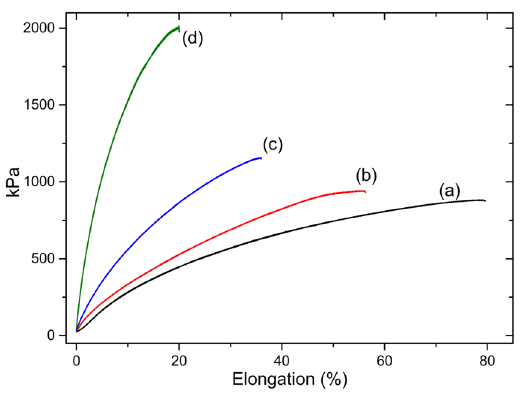
Figure 10. Stress-Strain (%) behavior of PPOB 40 -B-al 40 -S 20 ( a ), 1 st ( b ), 3 rd ( c ), 5 th ( d )